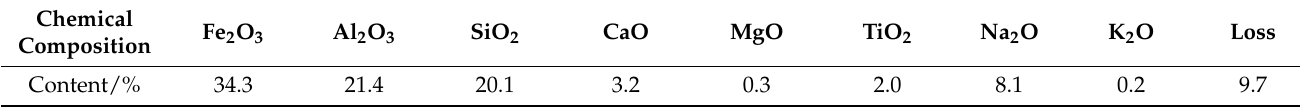
Table 1. Chemical constituents of Bayer red mud.